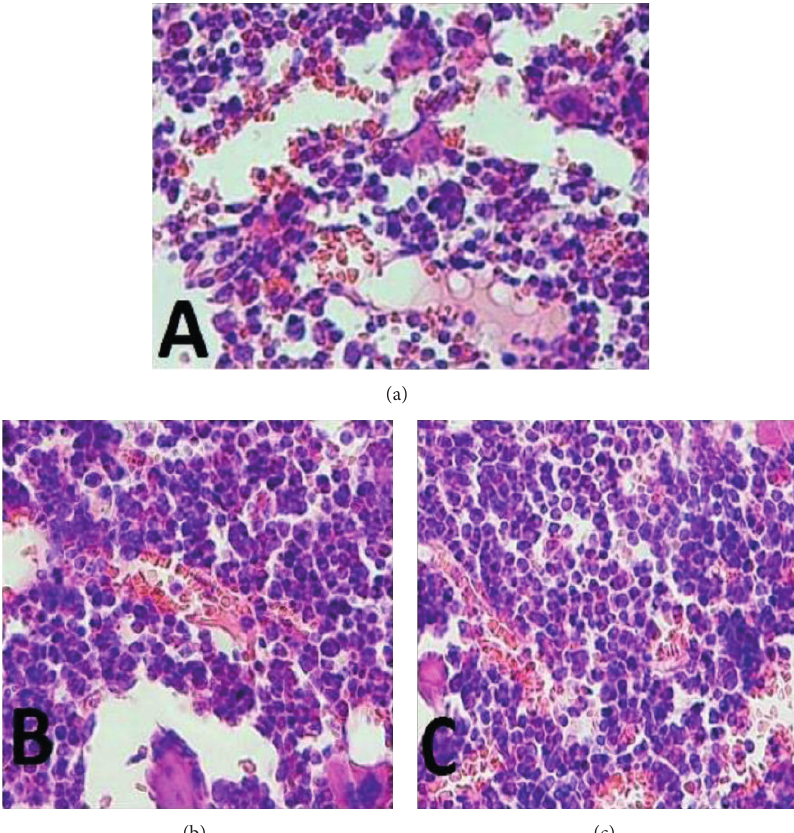
Figure 2: Myeloid hypoplasia in femur 24 hours after CP administration 70mg/kg; (a) compared with myeloid hyperplasia induced by administration of CCT fruits extract at 100 mg/kg; (b) & 200 mg/kg; (c) for 7 consecutive days before CP treatment. CP-induced myelosuppressive effects (a) and CCT led to marked proliferation and hypercellularity of immature myeloid elements after mice were treated with CP and mitigated the bone marrow suppression ((b) and (c)). Note the relative increase in the proportion of myeloid to erythroid precursors after CCT administration (hematoxylin and eosin-stained paraffin